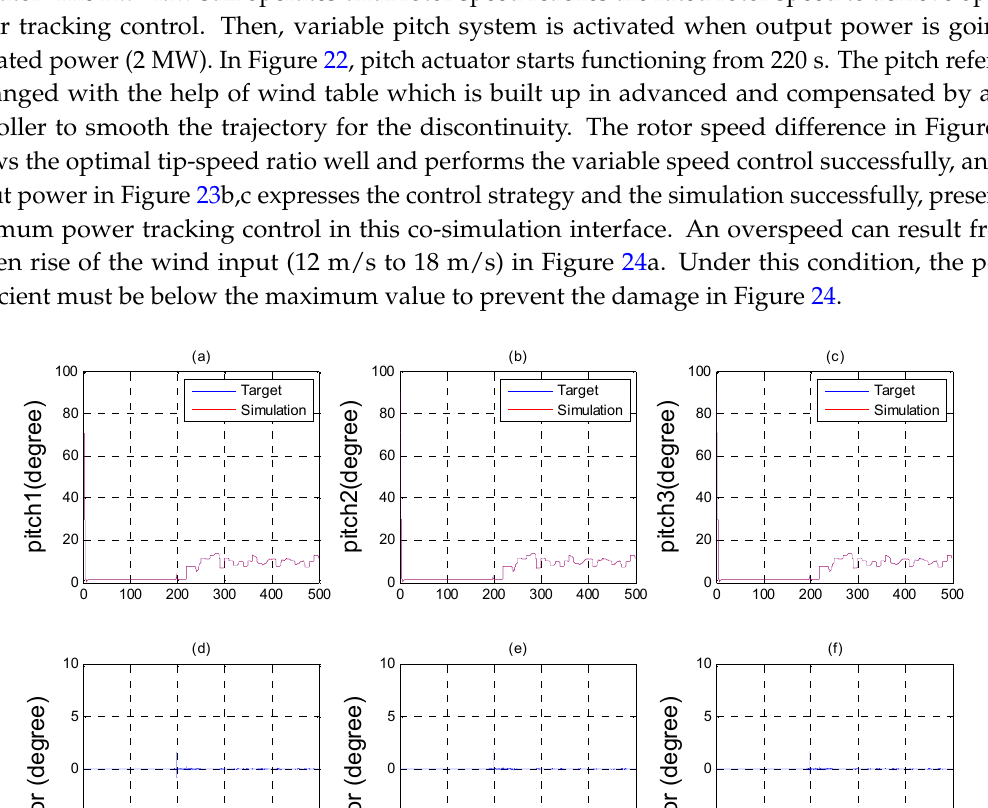
Figure 21. Wind input and overall efficiency in Region 2: ( a ) Wind input; ( b ) Overall power coefficient.